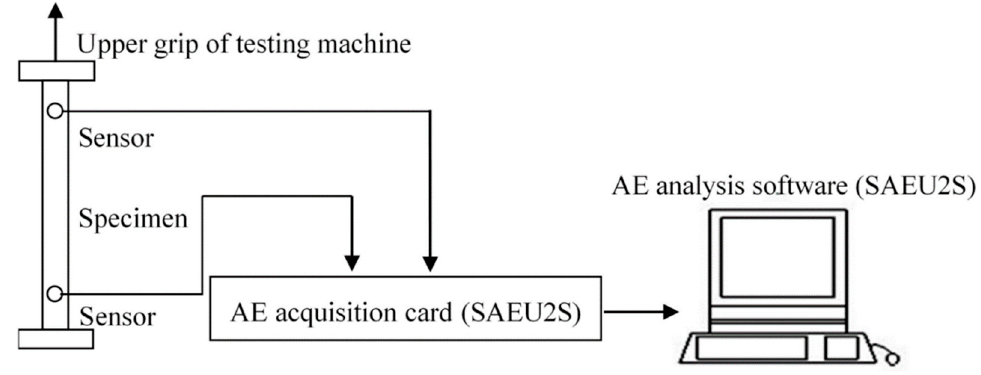
Figure 2. The tensile process of the 3D braided composites.